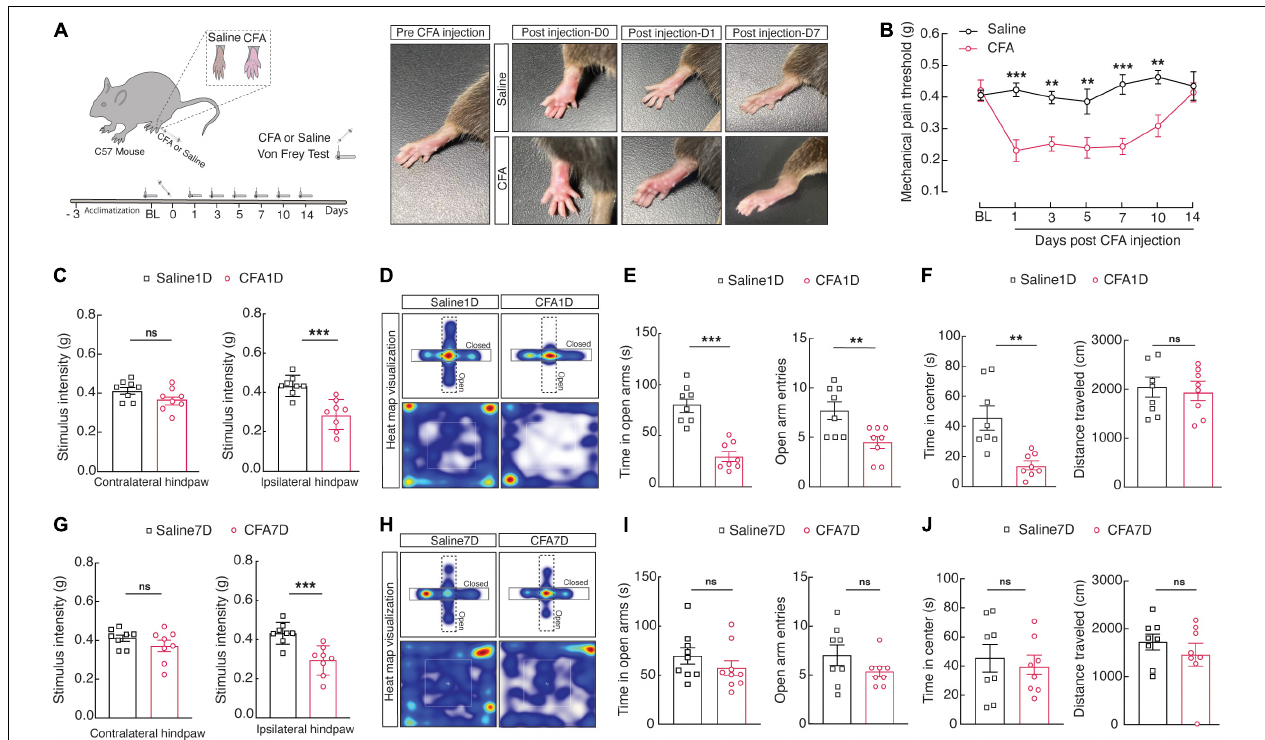
FIGURE 1 | CFA1D mice demonstrate anxiety-like behaviors in acute pain. (A) Schematic diagram of the experiment paradigms for the CFA injection. (B) Time course of CFA-induced mechanical sensitivity on days 1, 3, 7, 10, and 14 post injection. Mechanical pain threshold; two-way ANOVA with Bonferroni post hoc analysis [Time × group interaction, F (5,854) = 3.930 and P = 0.0016]. (C) Performance of stimulus intensity of the contralateral and ipsilateral hind paw in saline1D- and -CFA1D mice ( t 14 = 1.741 and P = 0.1037 in contralateral hind paw, t 14 = 4.393 and P = 0.006 in ipsilateral hind paw). Two-tailed unpaired t -test. (D) Representative animal heat tracks from saline1D- and CFA1D mice in EPM and OFT. (E,F) Performance of EPM and OFT on saline1D- and CFA1D mice (time in open arm; t 14 = 6.200 and P < 0.001, open arm entries; t 14 = 3.005 and P = 0.095, time in center; t 14 = 3.76 and P = 0.0021, distance traveled; t 14 = 0.56 and P = 0.58). (G) Performance of stimulus intensity of the contralateral and ipsilateral hind paw in saline7D- and CFA7D- mice ( t 14 = 1.185 and P = 0.2556 in contralateral hind paw, t 14 = 4.193 and P = 0.0009 in ipsilateral hind paw). Two-tailed unpaired t -test. (H) Representative animal heat tracks from saline7D- and CFA7D mice in EPM and OFT. (I,J) Performance of EPM and OFT on saline7D- and CFA7D- mice (time in open arm; t 16 = 1.118 and P = 0.2799, open arm entries; t 14 = 1.414 and P = 0.1792, time in center; t 14 = 0.5309 and P = 0.6038, distance traveled; t 14 = 0.9066 and P = 0.38). All data are expressed as mean ± SEM. n = 8 mice per group. All data are expressed as mean ± SEM. ** P < 0.01, and *** P < 0.001; ns, not